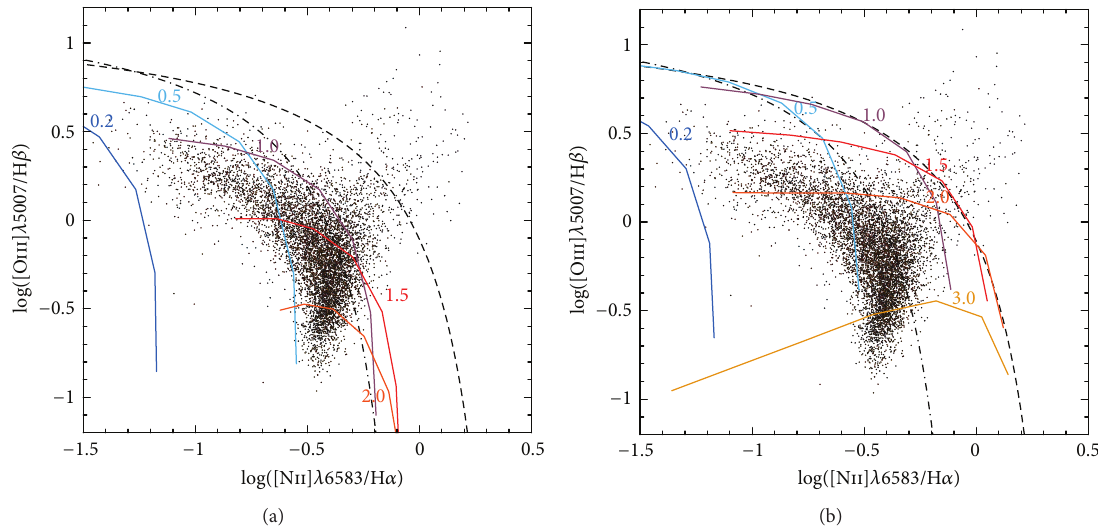
Figure 4: (a) [Oiii] 𝜆 5007/H 𝛽 versus [Nii] 𝜆 6583/H 𝛼 diagnostic diagram for the ∼ 7000 ionized regions shown in Figure 3(a). The color solid- lines represent the expected line ratios derived from the MAPPINGS-III ionization models, based on an instantaneous zero-age starbust model based on the PEGASE spectral energy distribution. Each solid-line corresponds to a different metallicity, which is indicated with the corresponding label in units of solar abundance, with a different ionization strength that varies from strong to weak ionizations from left to right in each line. (b) Identical diagram to that in (a), with the only difference that in this particular case the color solid-lines represents the expected line ratios for a continuous starburst model after 4Myr of its ignition. In ((a), (b)), the dot-dashed and dashed-line represent, respectively, the Kauffmann et al. [26] and Kewley et al. [27] demarcation curves. They are usually invoked to distinguish between classical star-forming objects (below the solid line) and AGN powered sources (above the dashed line). Regions between both lines are considered intermediate